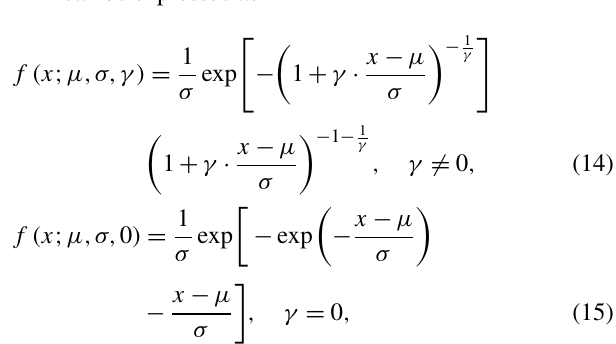
PDF can be expressed as